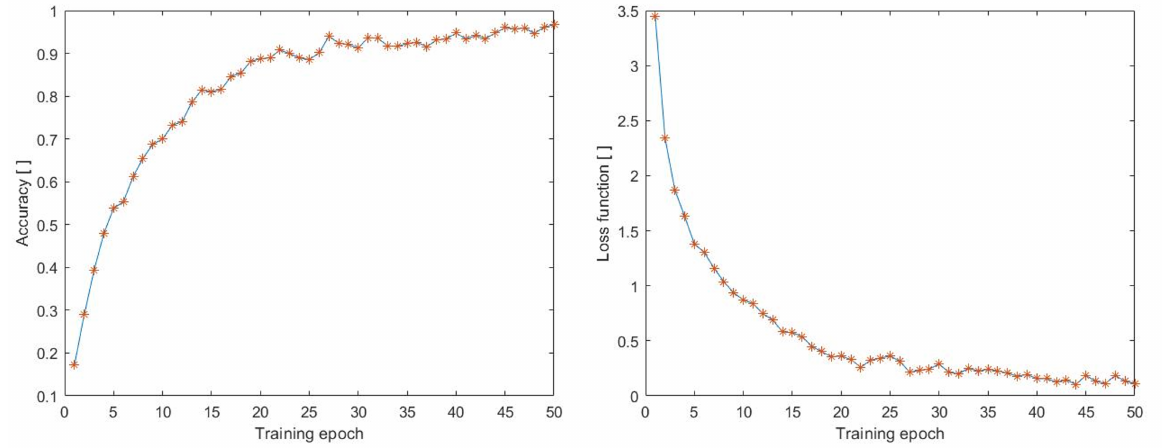
Figure 10. Accuracy during training process on the dataset (UCF50mini).